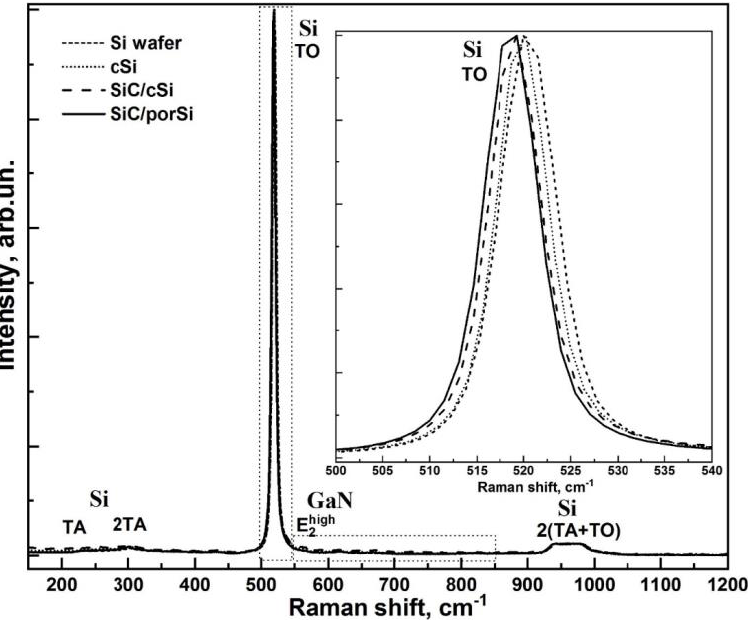
Figure 2. Raman spectra of epitaxial heterostructures grown on three types of substrates.